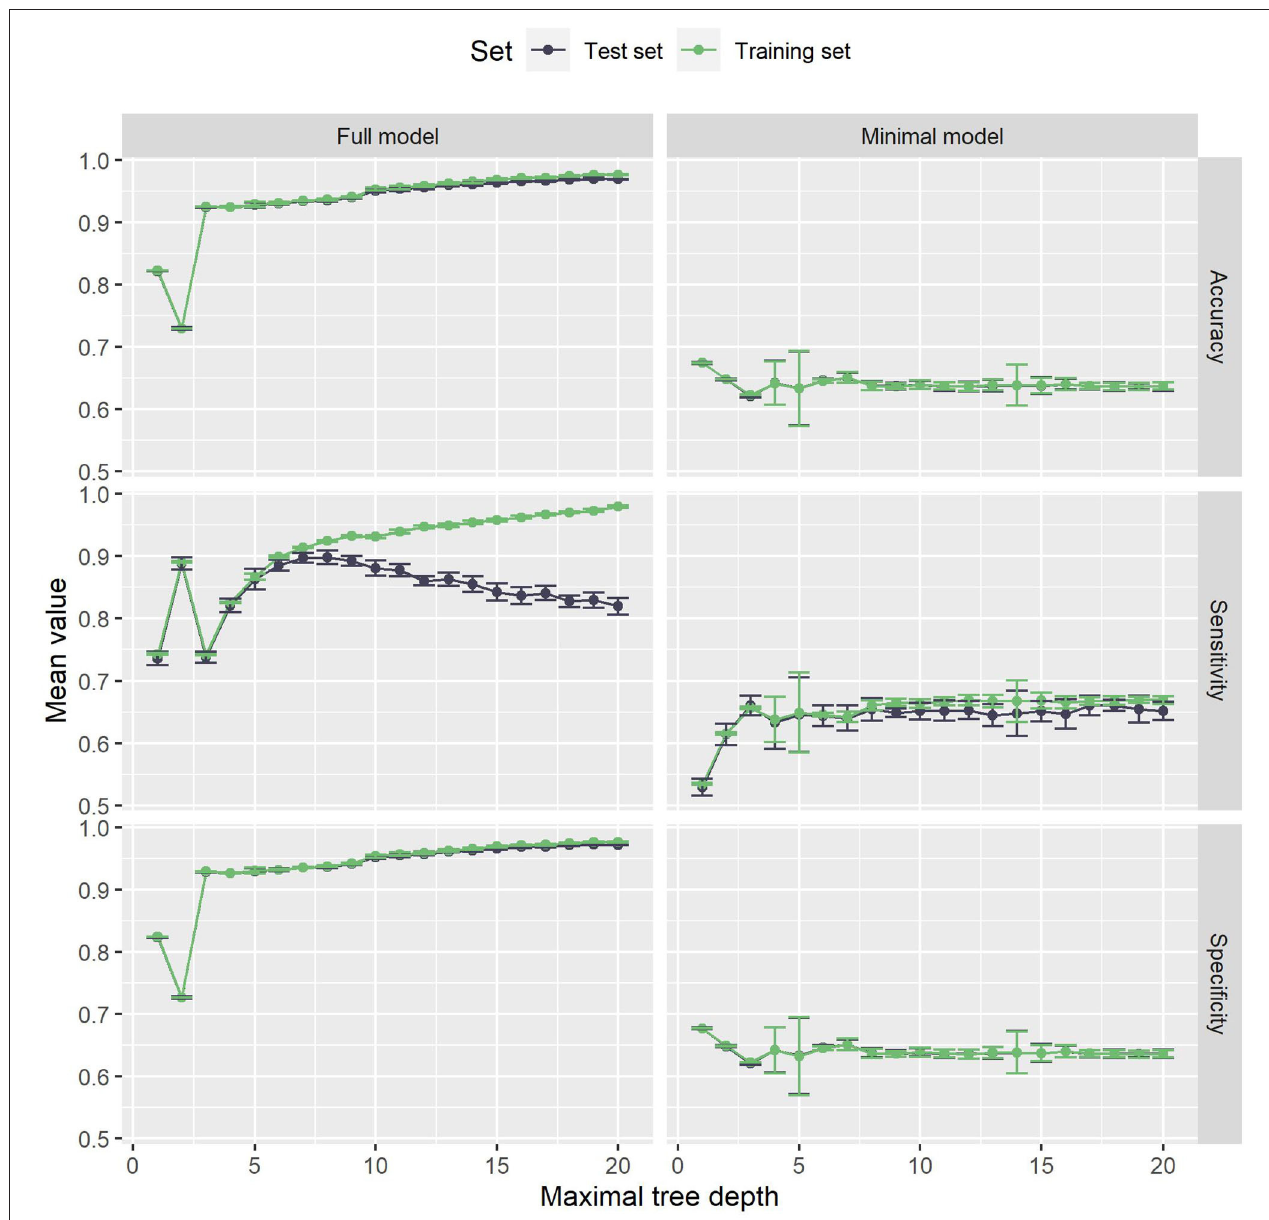
FIGURE 7 | Various metrics on the Decision Tree models. The left panels are the full model, while the right panels are the minimal model. The color denotes whether the training or the test set was used to produce these metrics. On the x-axis, various maximal tree depths were analyzed. For the full model, there is major overfitting. The test set sensitivity quickly drop below the training set sensitivity for higher maximal tree depths. For the minimal model, the sensitivity also drops below the training set’s